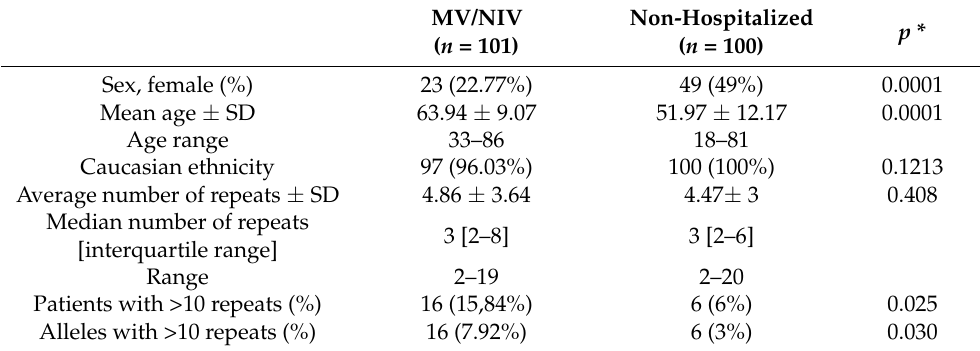
Table 4. Demographic data and C9orf72 hexanucleotide expansions in the validation cohort.